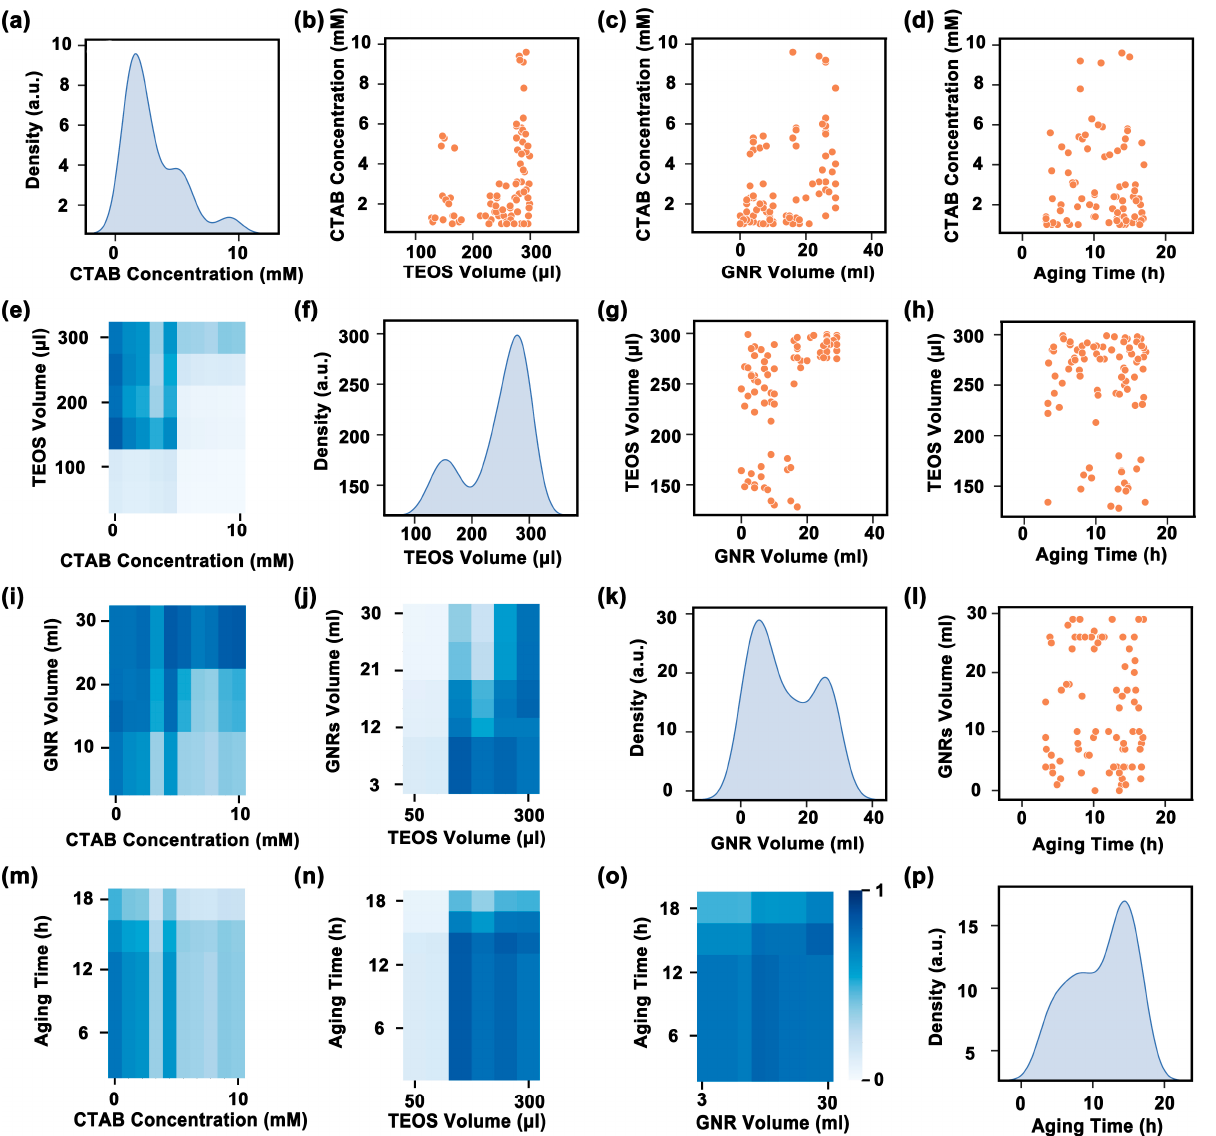
Figure 3. Statistical analysis based on ML predictions. Kernel density estimates of the predicted success group by the XGBoost model regarding ( a ) CTAB concentration, ( f ) TEOS volume in a single injection, ( k ) GNR volume, and ( p ) aging time, respectively. The scatter distribution of the predicting success group in the parameter space of the four foremost factors: ( b ) CTAB concentration versus TEOS volume in a single injection, ( c ) CTAB concentration versus GNR volume, ( d ) CTAB concentration versus aging time, ( g ) TEOS volume in a single injection versus GNR volume, ( h ) TEOS volume in a single injection versus aging time, and ( l ) GNR volume versus aging time. The heatmap of predictions from the trained model represented by the matrix formed by the four most important features: ( e ) TEOS volume in a single injection versus CTAB concentration, ( i ) GNR volume versus CTAB concentration, ( j ) GNR volume versus TEOS volume in a single injection, ( m ) aging time versus CTAB concentration, ( n ) aging time versus TEOS volume in a single injection, and ( o ) aging time versus GNR volume. All heatmaps share an identical color bar in values within the subgraph ( o ).